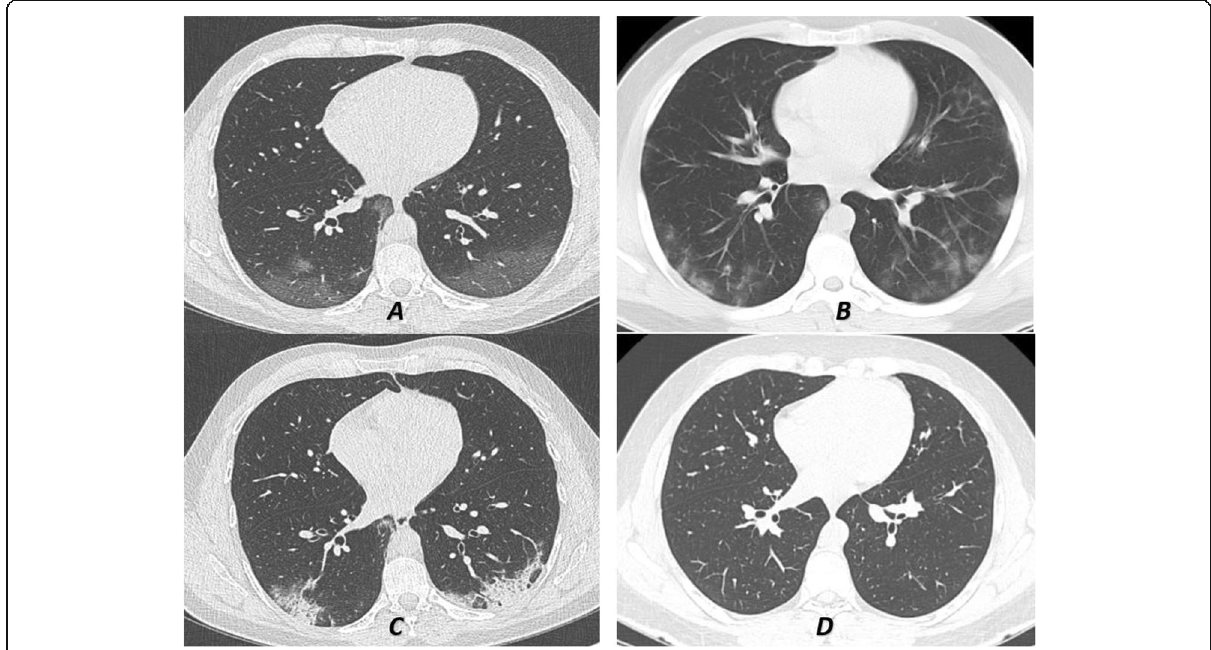
Fig. 4 A 27-year-old medical staff who contacted a COVID 19 positive patient and complained of dyspnea and fever. He was diagnosed to have COVID-19 confirmed by a positive RT-PCR test. The 1st CT (lung window) was done 2 days after the onset of the symptoms ( a ) revealed the presence of a bilateral lower lobar posterior and peripheral ill-defined veiling of ground-glass opacity. Follow-up CT ( b ) after 7 days from the onset of symptoms showed multi-lobar subpleural more defined multiple ground-glass patches which denoted disease progression. Peripheral subsegmental consolidative patches with fewer areas of ground-glass opacity were noted in ( c ) which was done after 12 days from the onset of symptoms (stage 3). ( d ) represented CT at the 4th stage after 18 days from the onset of symptoms revealed complete resolution of the previously noted features (negative